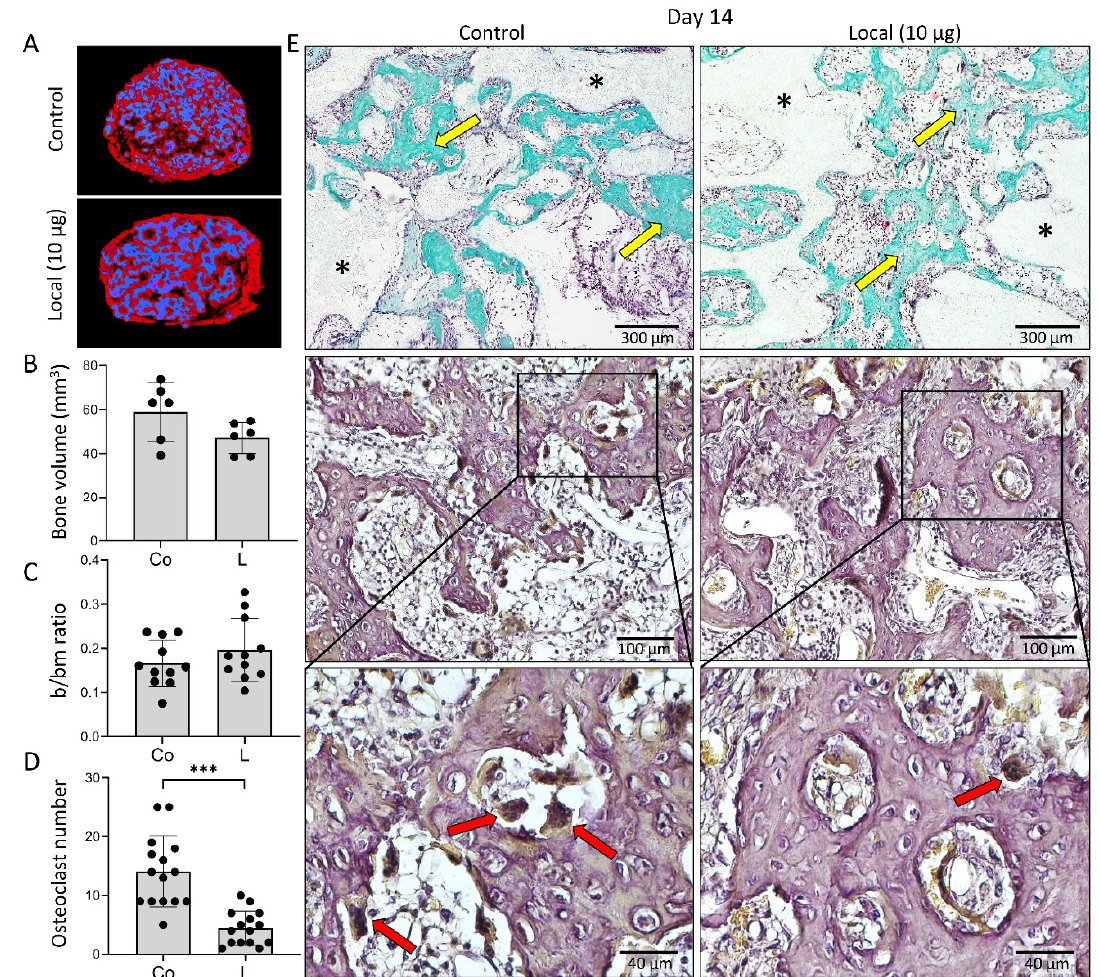
Figure 1. Addition of zoledronate (ZOL) to ABGS (rhBMP6/ABC) implants with ceramics had no effect on the bone formation 14 days after subcutaneous implantation but decreased the number of osteoclasts. ( A ) Newly formed bone (red) and ceramics (blue) are shown on 3D reconstruction slices among experimental groups. ( B ) MicroCT determined bone volume (mm 3 ) and ( C ) histomorphometrically determined bone/bone marrow (b/bm) ratio among control (Co) and locally added ZOL (L) implants. ( D ) Number of osteoclasts counted on histological sections. ( E ) Histological sections of BCS induced by implants with and without ZOL. Sections were stained with Goldner where newly formed bone is marked with yellow arrow, while black asterisks indicate ceramic particles (1st row). Osteoclasts (red arrows) were localized on HE-stained sections using histochemical detection of TRAP (2nd and 3rd row). Scale bars are shown in the lower right corner. All P values below 0.05 were considered significant and are marked with asterisks as follows: * ( p ≤ 0.05), ** ( p ≤ 0.01), *** ( p ≤ 0.001).